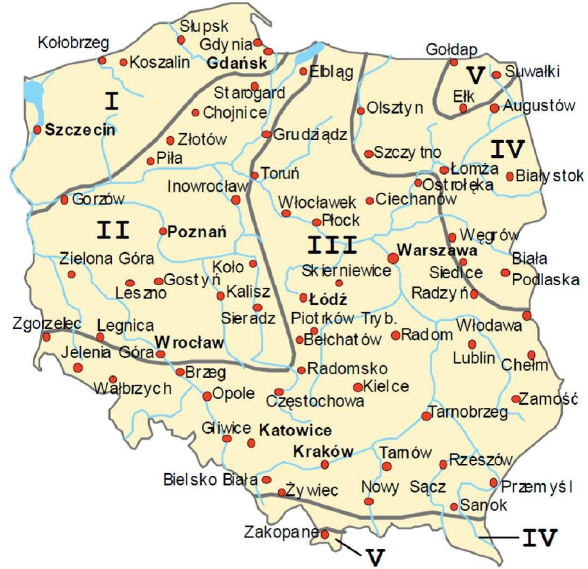
Figure 1. Poland’s climate zones. Source: [24].